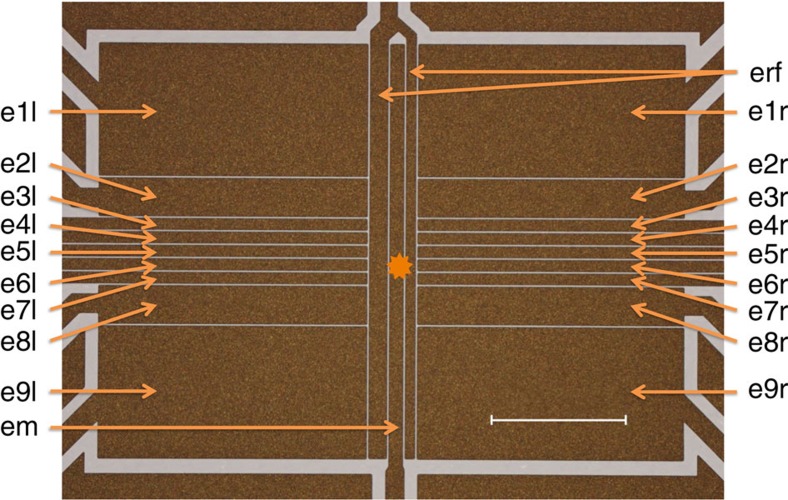
Surface-electrode trap.Linear Paul trap in final fabrication steps. Ions are trapped in the position denoted with a star, ≈50 μm from the trap surface. The length of the scale bar is 500 μm.